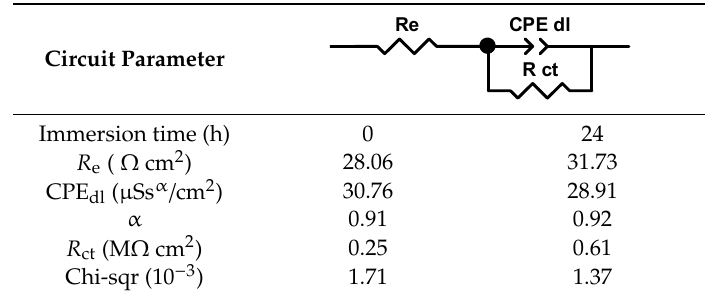
Table 2. Values of the electrical parameters value of the equivalent circuit used to fit the spectra of the non-anodized specimen.